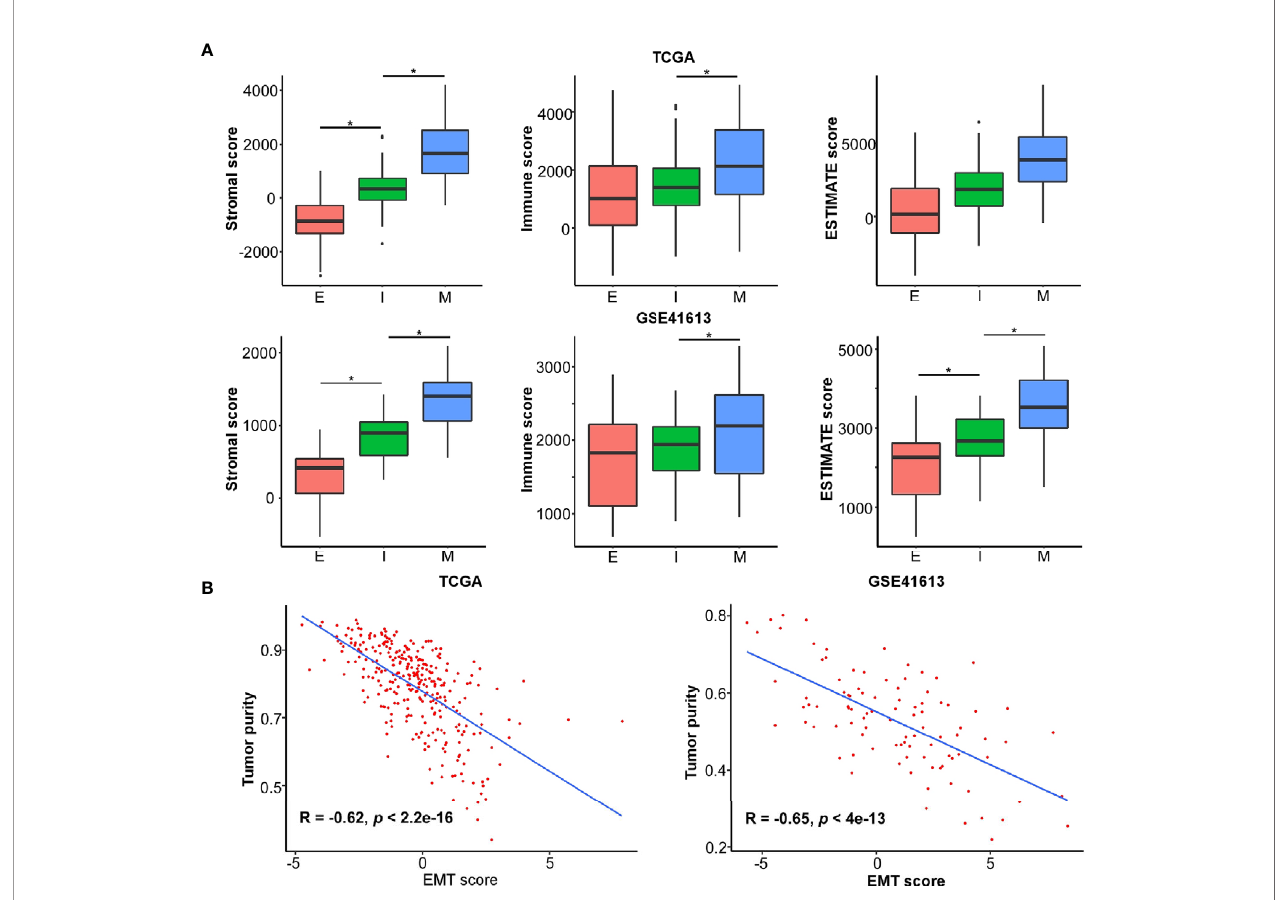
FIGURE 3 | EMT signature is negatively associated with tumor purity and likely emanates from stroma in OSCC. The ESTIMATE method is applied to determine the cellular components and tumor purity. (A) The stromal score, immune score, and ESTIMATE score in each EMT subtype. * p value < 0.05, mean ± s.d., student ’ s t - test. (B) The correlations of EMT score and tumor purity in OSCC. The R and p values were calculated using Pearson correlation coef fi